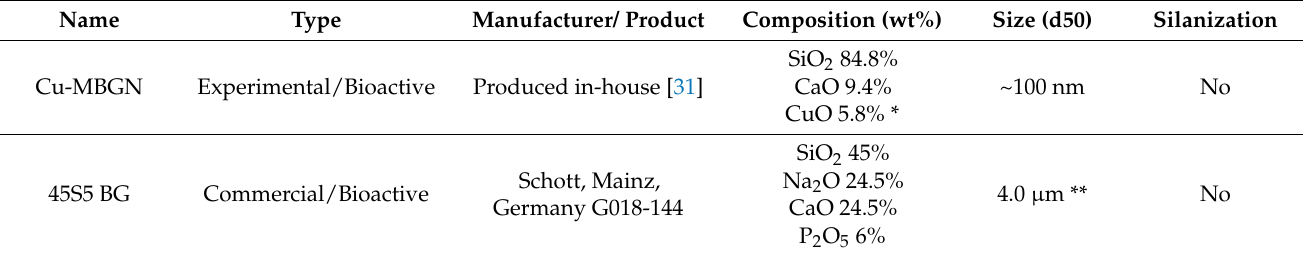
Table 2. Characteristics of fillers used in the present study (data provided by the